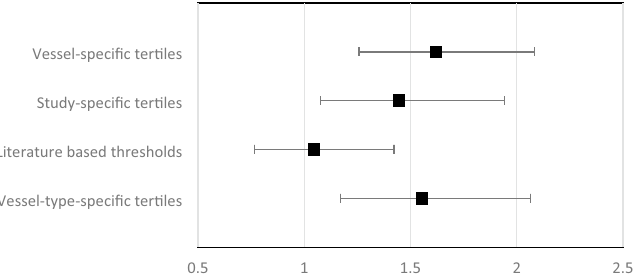
Figure 4. The predictive value of low WSS as predictor for plaque progression for the four different thresholding